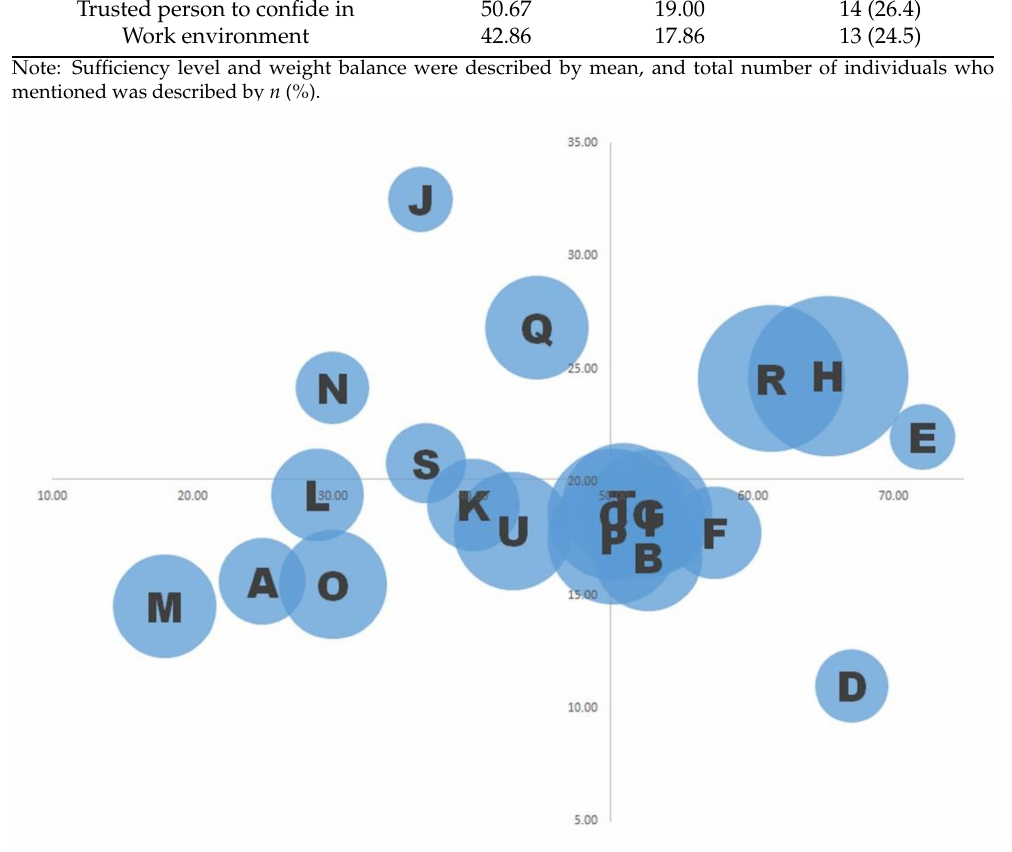
Figure 1. Bubble plot of work-improvement needs items in SWING for whole subjects. The vertical axis is mean weight balance and horizontal axis is mean sufficiency level. Centred on the intersections set by the overall mean weight and sufficiency, four patterns, such as the upper left quadrant with high importance and low sufficiency, were obtained. The items that were mentioned by many people are depicted as large, whereas items that were not mentioned much are depicted as relatively small bubbles. The items placed around the intersections and overlapped are B, C, G, I, P, and T. Those items were not well characterised in terms of both sufficiency and weight in this study. Due to the limit